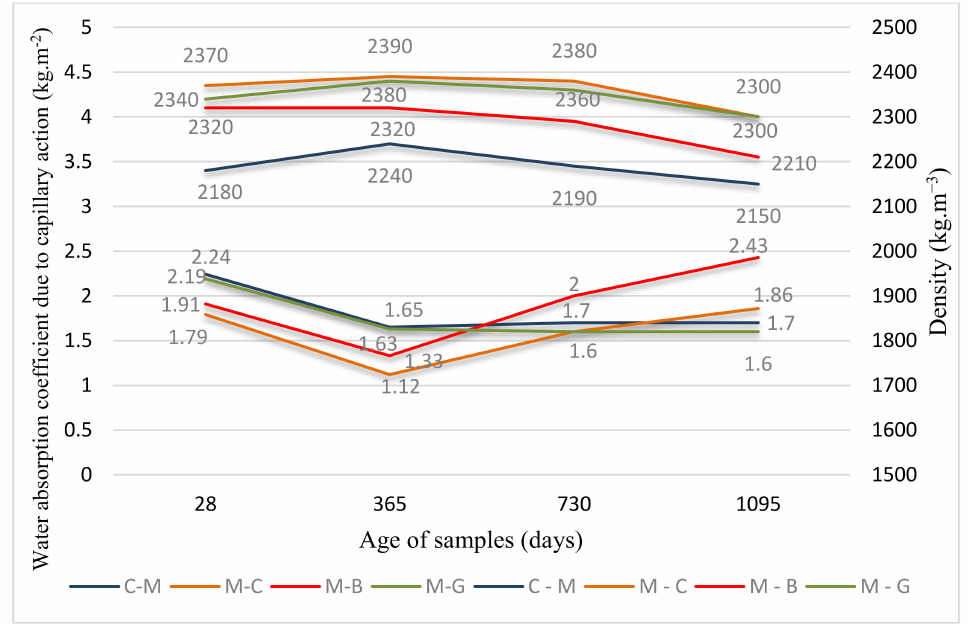
Figure 6. Results of density and water absorption coe ffi cient due to capillary